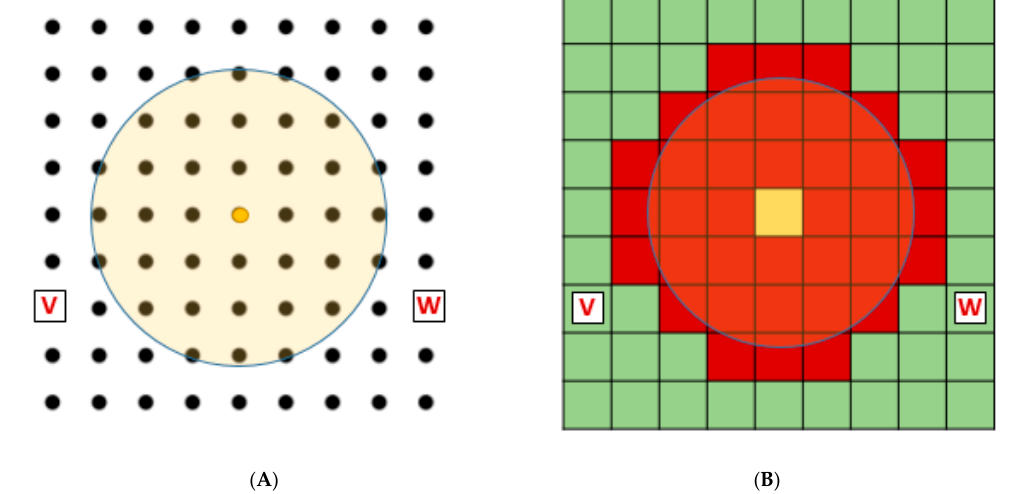
Figure 1. Visual representation of examples of cellular automata (CA) models using either ( A ) points in a CA-E model or ( B ) cells in a CA-P model. In each case a single population of weeds is analysed across a 9 × 9 lattice. In the CA-E model ( A ), there is typically one plant measured at each point, whereas in the CA-P model ( B ), there are spatially defined sub-populations containing any number yellow position can disperse their seeds or pollen to the points or cells indicated by the